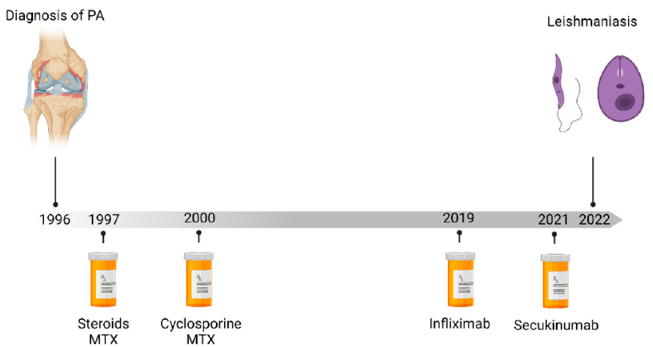
Figure 1. Timeline of treatment of psoriasis until diagnostic of visceral leishmaniasis. Abbreviations: MTX: metothrexate.